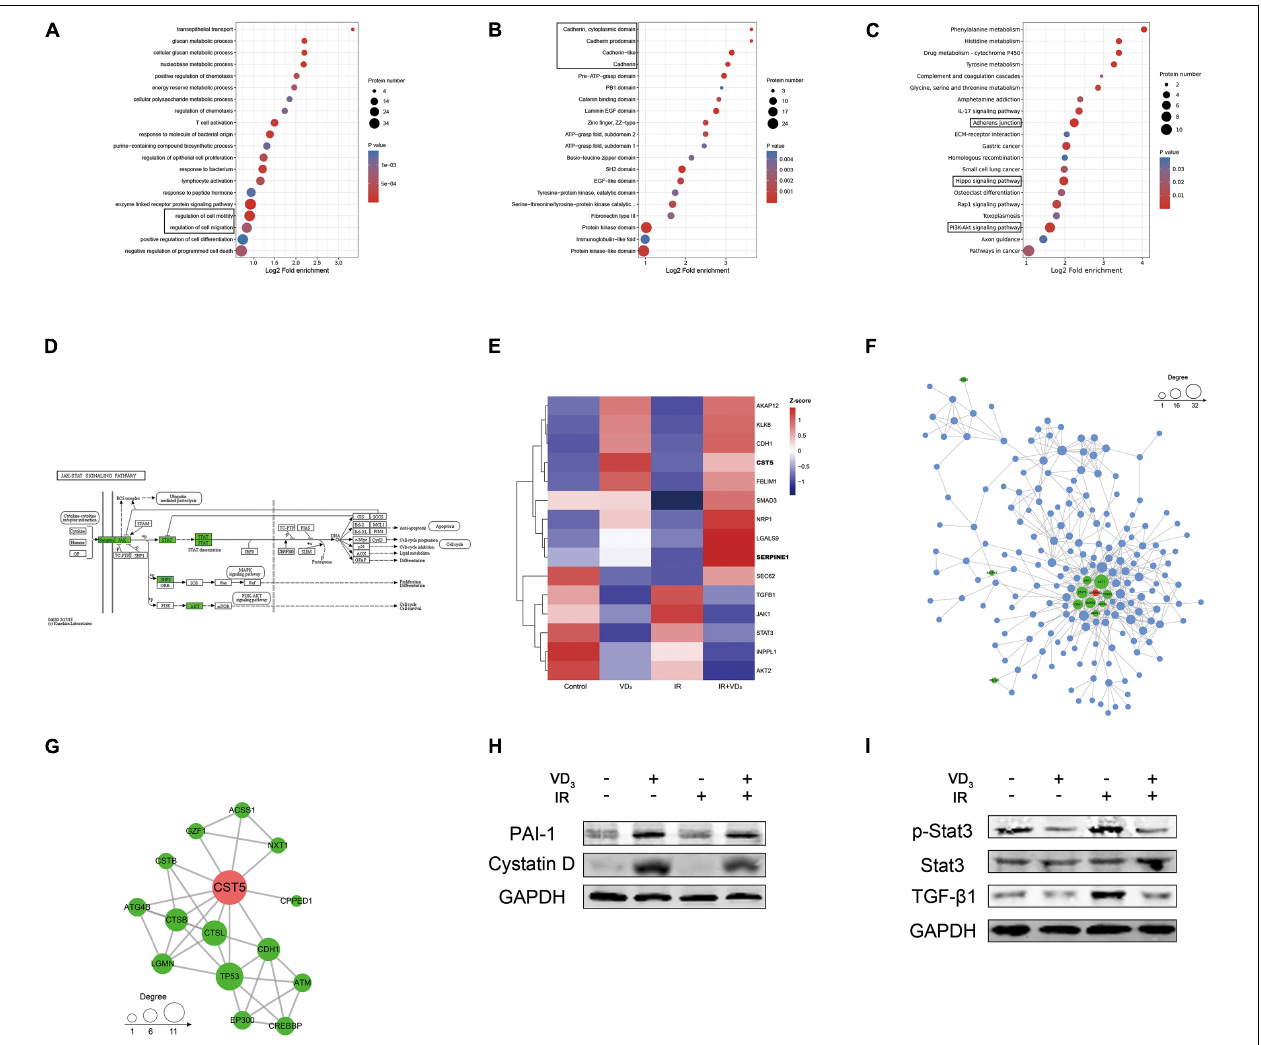
FIGURE 4 | Proteomics revealed influence on EMT. (A–C) Functional enrichment analysis of differentially expressed proteins based on Gene Ontology (GO) terms. The circle size indicates the number of enriched genes in each term. Each color indicates a different p -value as indicated. The fold enrichment represents the ratio of enriched proteins in the selected term to the total number of proteins in the term. (D) The Kyoto Encyclopedia of Genes and Genomes (KEGG) pathway analysis of differentially expressed proteins identified by proteomics. (E) Hierarchical clustering analysis of representative proteins associated with EMT, relative increase or decrease in expression was shown by indicated colors. (F,G) Protein-protein interaction (PPI) network among the heatmap proteins. (H) Western blot validation of the changes in cystatin D and PAI-1 protein expression with indicated treatment. (I) Immunoblot analysis of the changes in JAK/STAT3 and TGF- β 1/Smad3 signaling pathway protein expression with indicated